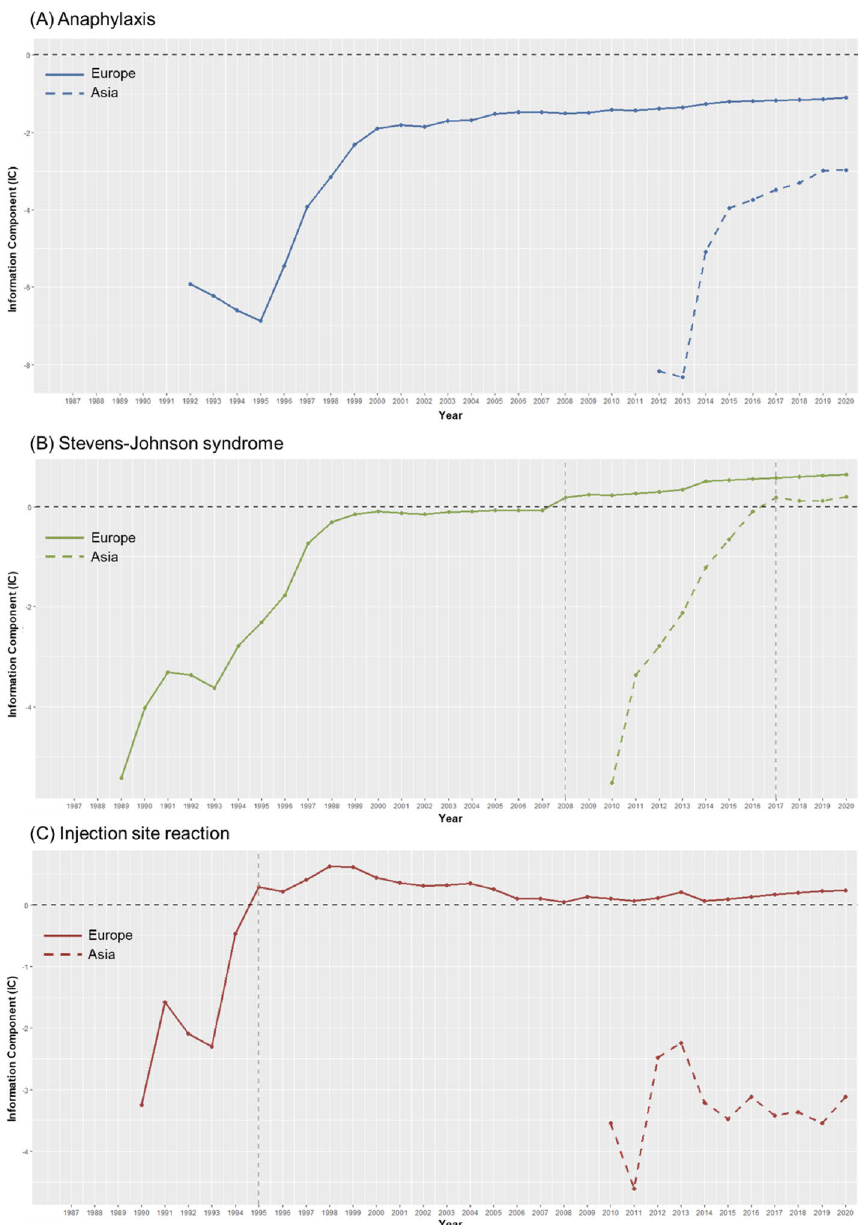
Figure 3. Trends of information component over time for anaphylaxis, Stevens–Johnson syndrome, and inject site